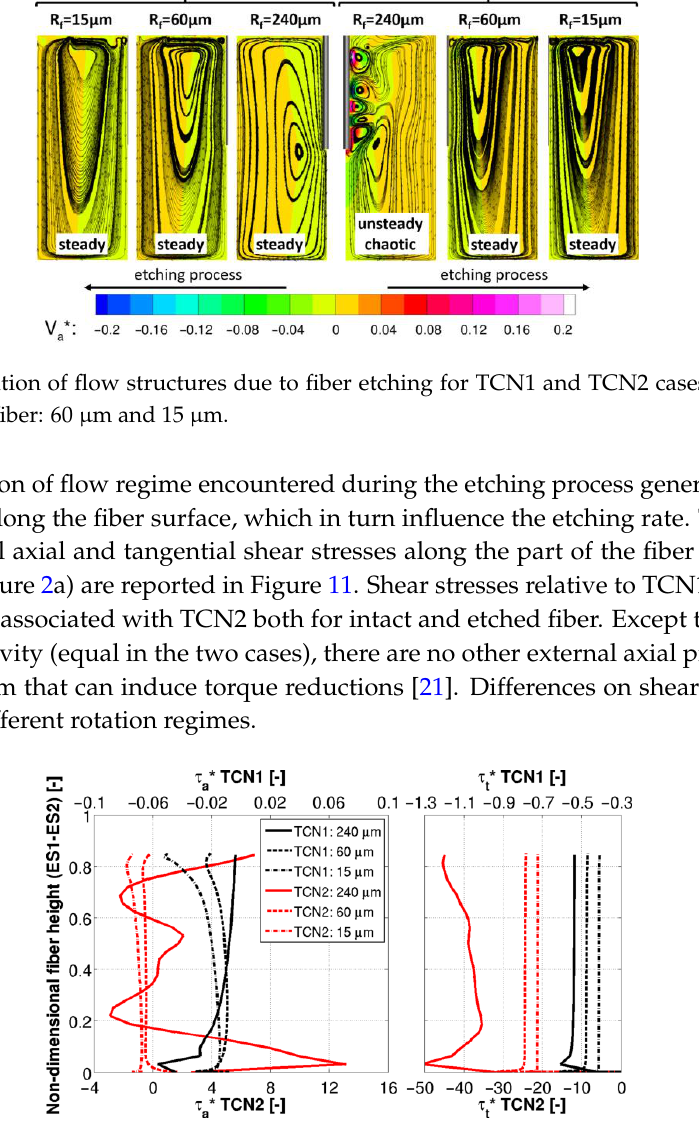
Figure 10. Variation of flow structures due to fiber etching for TCN1 and TCN2 cases. Intact fiber: 240 μm; etched fiber: 60 μm and 15 μm.